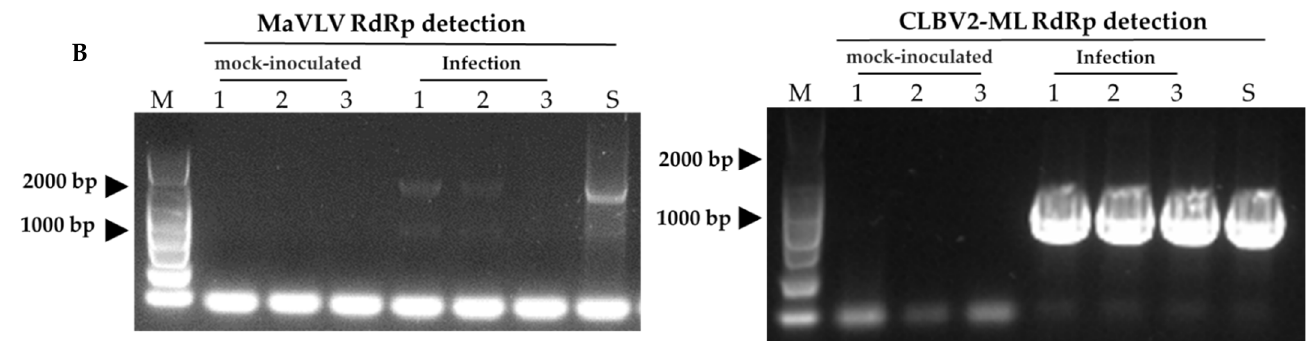
Figure 7. Symptoms on leaves of N. benthamiana and Morus alba infected by MaVLV, CLBV-ML2, and virus detection. ( A ) No symptoms on leaves of N. benthamiana and Morus alba . ( B ) RT-PCR detection of the infected leaves at 10 dpi. Lane 1 and 2: N. benthamiana , Lane 3: Morus alba , S: sample cDNA.